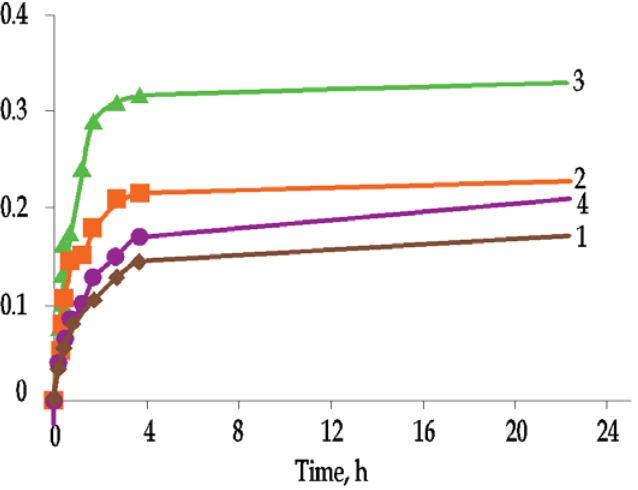
Figure 9. Surface water absorption of exterior plaster samples on plastic strip: (1) acrylic plaster, (2) silicate plaster, (3) mineral plaster and (4) silicone plaster (author’s archives based on [28]).